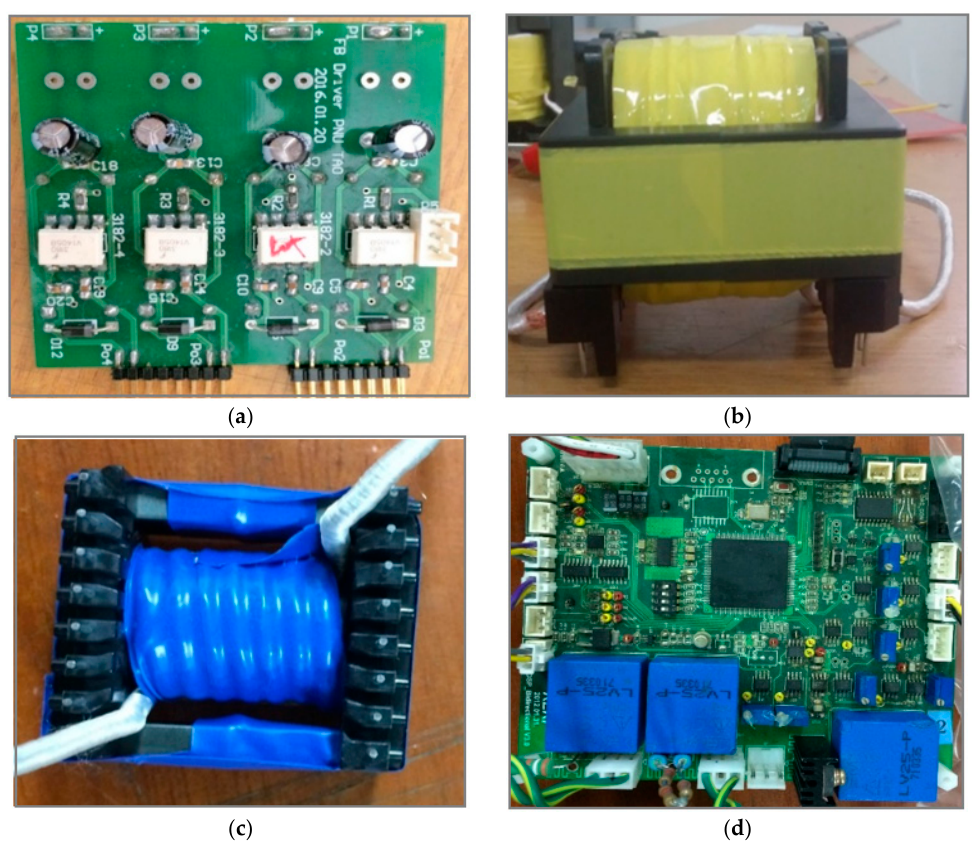
Figure 7. DAB-IBDC converter sub circuits and magnetic components. ( a ) MOSFET driving circuit; ( b ) Transformer; ( c ) Inductor; ( d ) Digital controller.